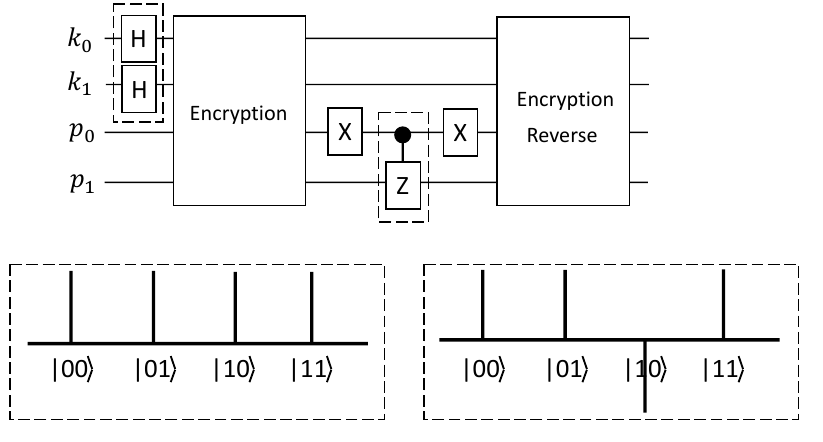
Figure 8. Oracle for Grover key